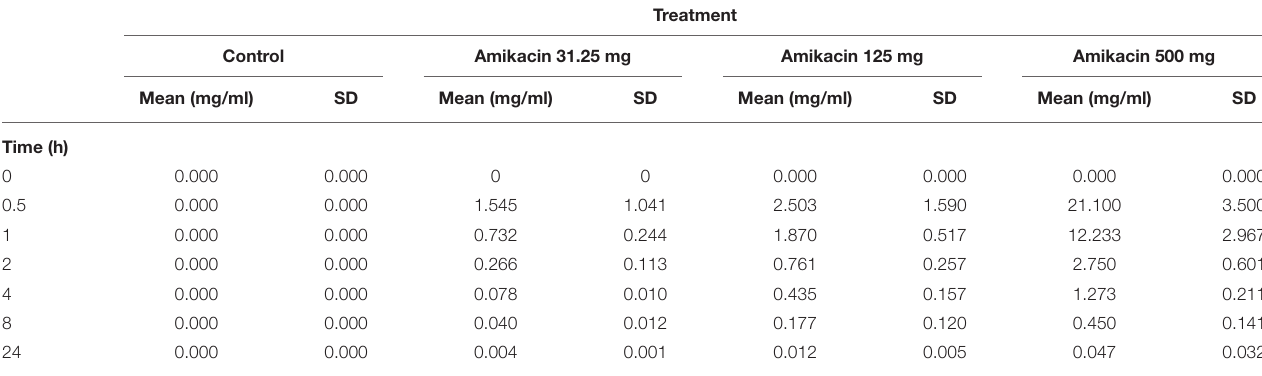
TABLE 1 | Mean ± SD synovial fluid amikacin concentrations over 24h following a single intra-articular administration of amikacin at one of three doses (500, 125, or 31.25mg) or the control (LRS, n = 3 horses per group).